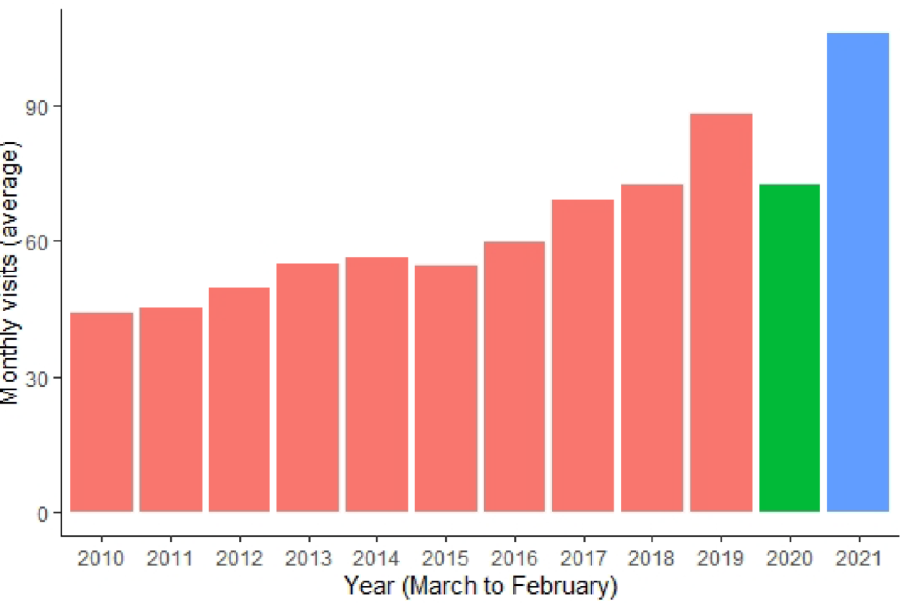
Figure 1. Average monthly ER referrals between the years 2010–2021. X axis values relate to “pandemic years”, i.e., referrals between March in the relevant year to February in the following year, expect for 2021 were data were obtained only for the months March to December.